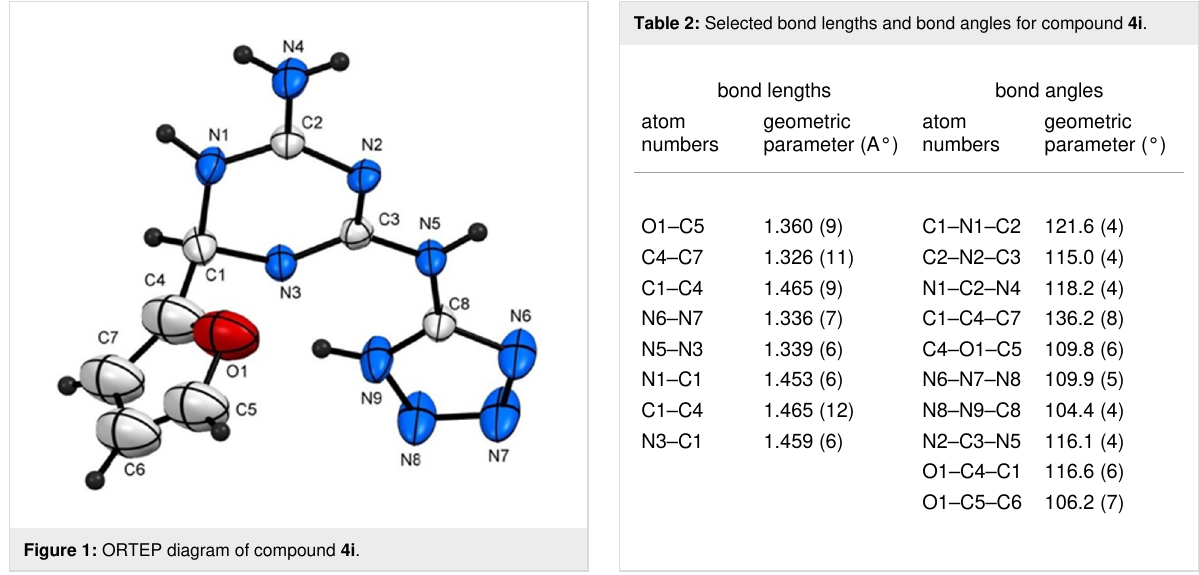
densation reaction with aromatic aldehydes 2 to afford 7 . The nucleophilic attack of the secondary amine in 7 to the arylidene carbon gives rise to the formation of 6-aryl-1-(1 H -tetrazol-5- yl)-1,2-dihydro-1,3,5-triazine-2,4-diamine intermediate 8 (route a) or the nucleophilic attack of the primary amine in 7 to the